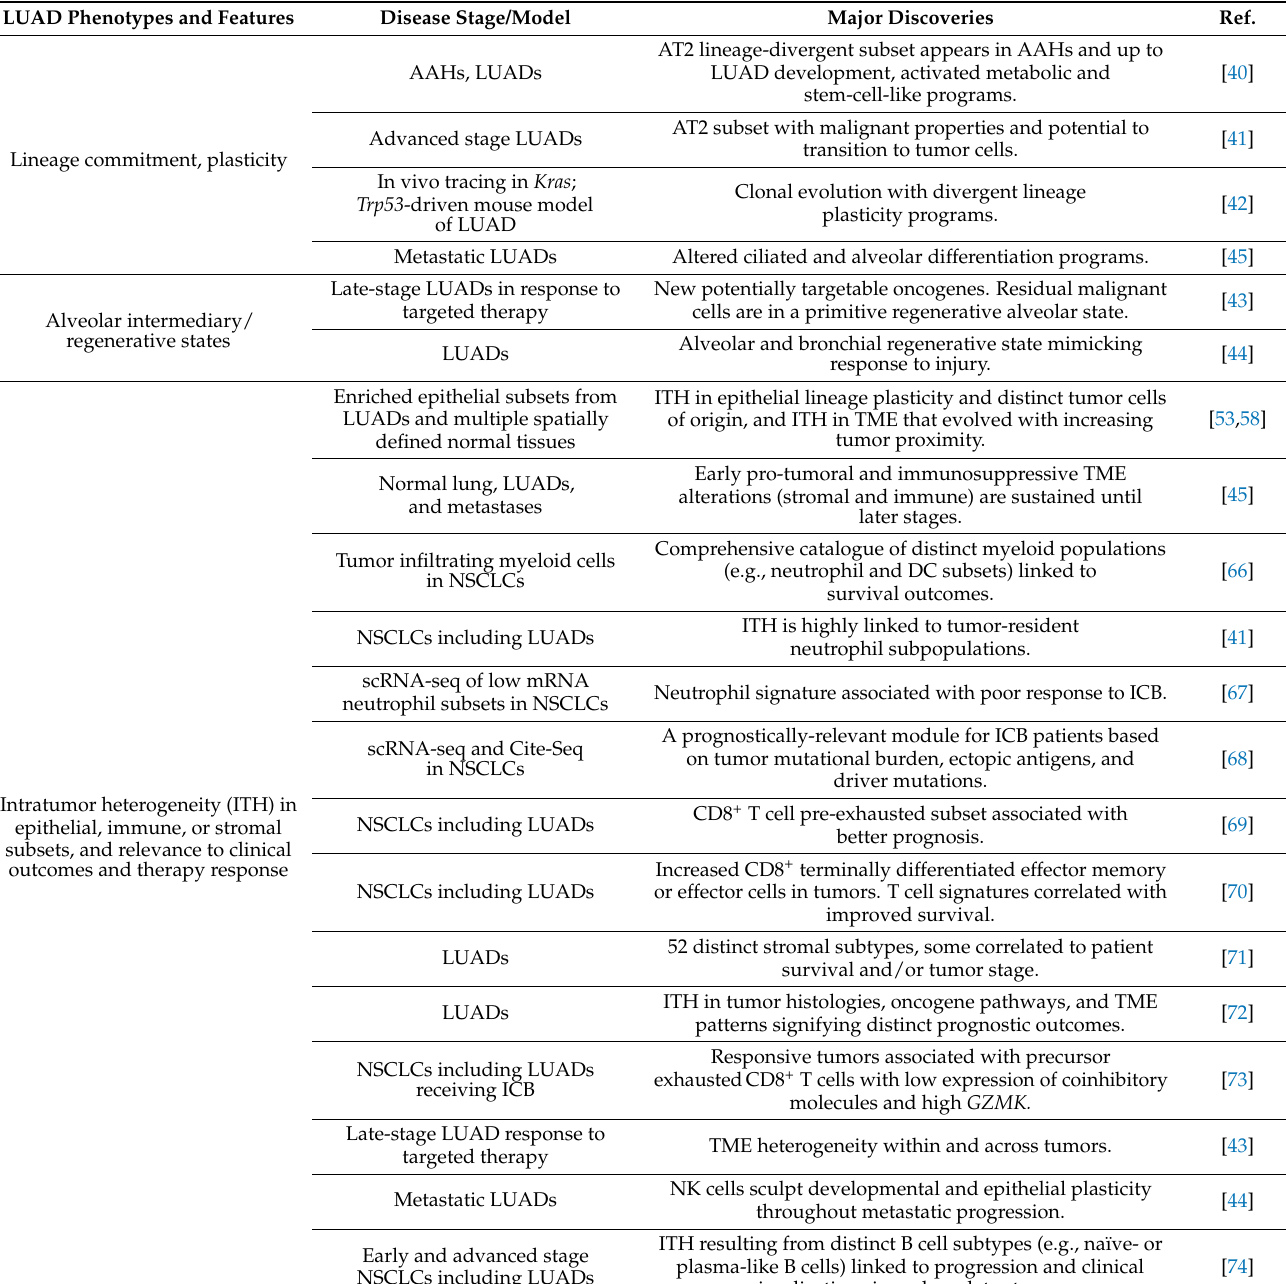
Table 1. List of LUAD scRNA-seq studies that are summarized in this review and grouped by LUAD phenotypes and